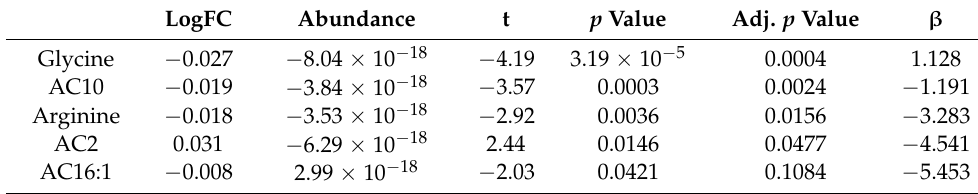
Table 2. Linear models with covariate